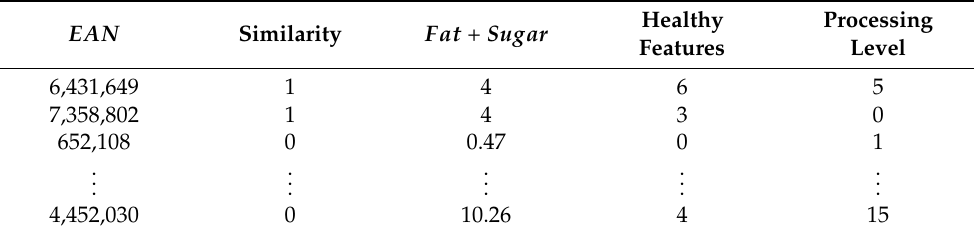
Table 15. HTH-BD: Example of a matrix with the considered criterions as columns after sorting the products.